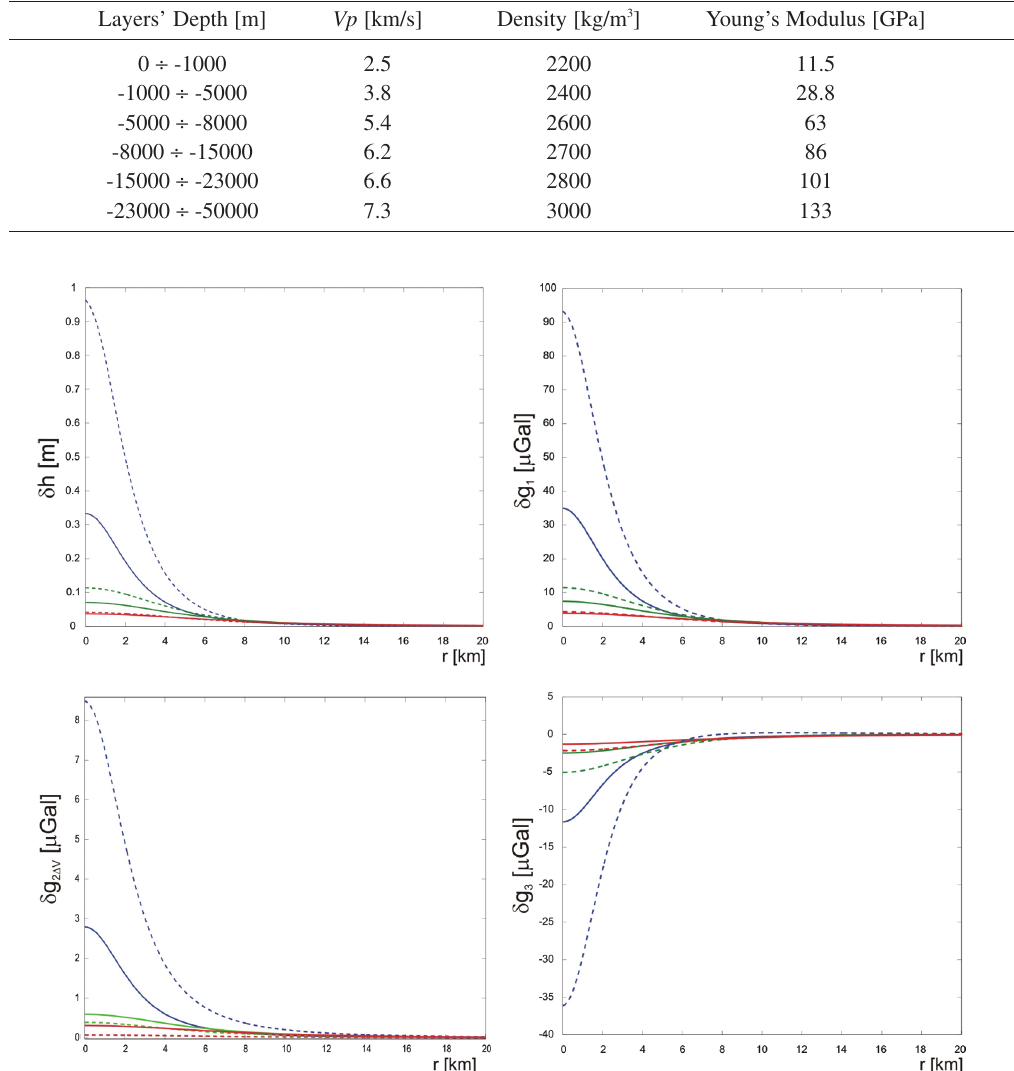
Table I . Medium properties of the multilayered model.